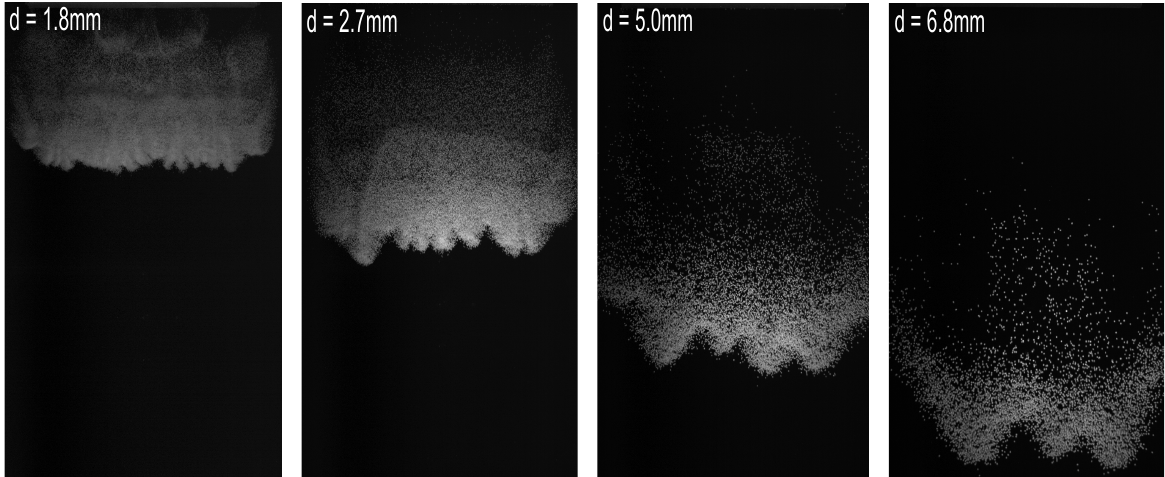
Fig. 4. Video stills taken at ˜ t = 50 from experiments conducted at a slope angle of 65 ◦ using 2100cm 3 of: 1.8mm, 2.7mm, 5.0mm and 6.8mm diameter EPS beads.